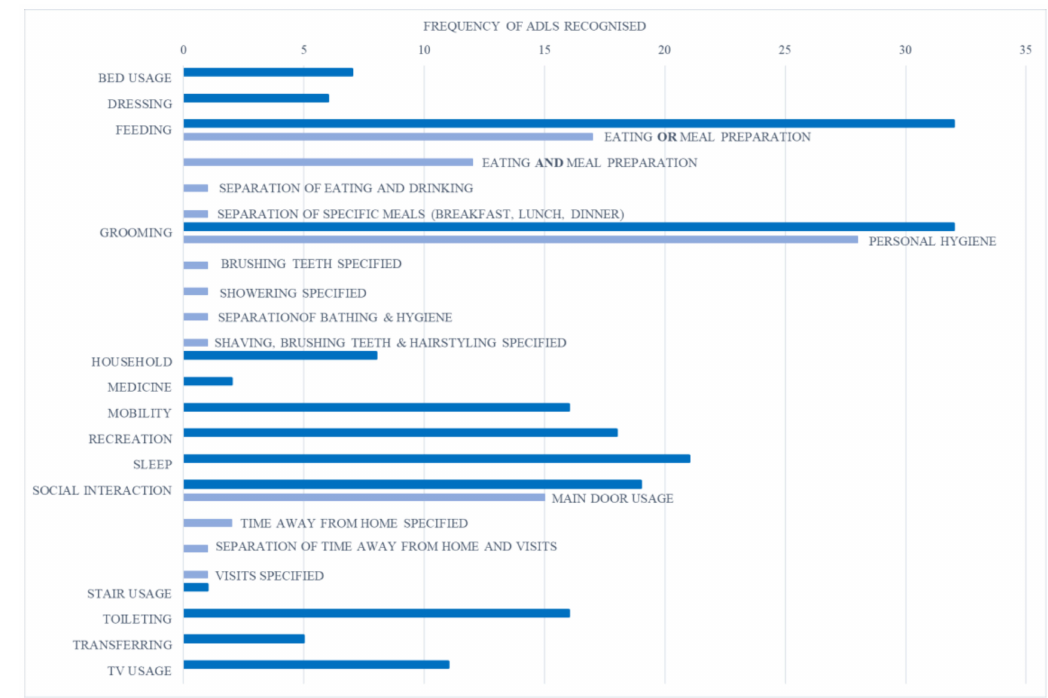
Figure 2. Frequency of ADL recognition by the identified systems. “FEEDING”, “GROOMING”, and “SOCIAL INTERAC- TION” include sub-activities, which were specified by some systems.